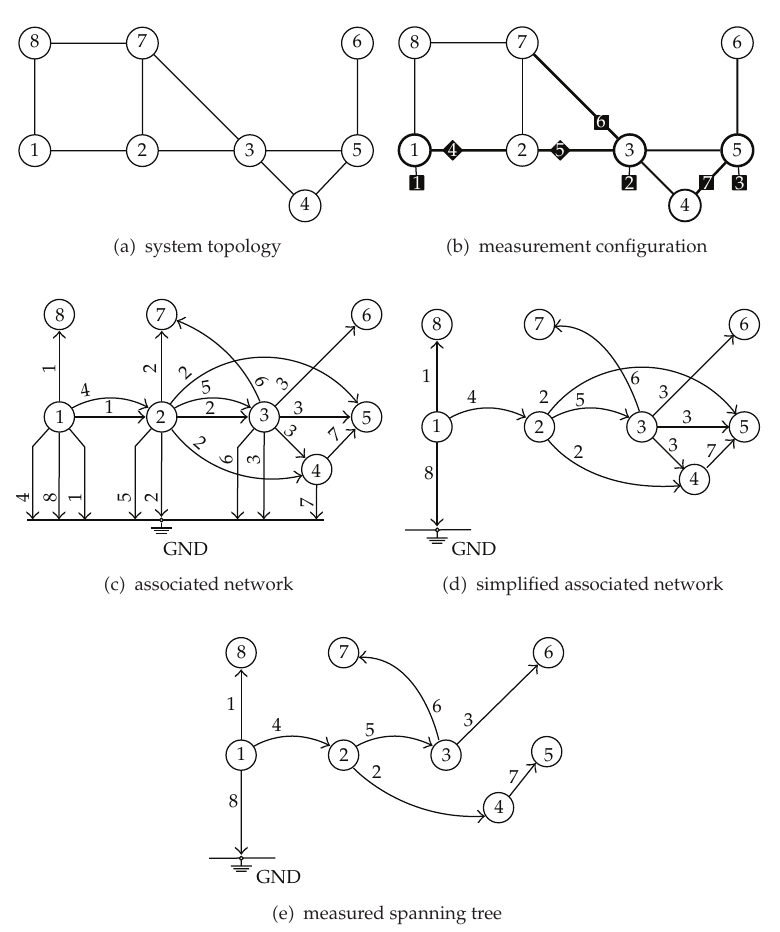
Figure 9: Electric power system